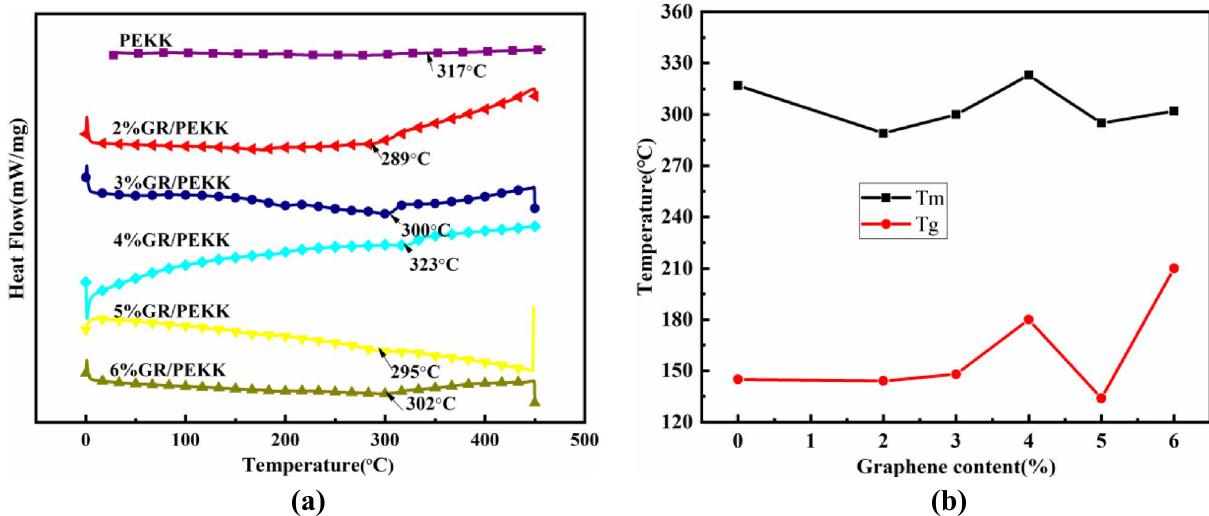
Figure 4. DSC curve and transition temperature and melting temperature of different graphene/PEKK composite materials: ( a ) DSC, ( b ) T g – T m .